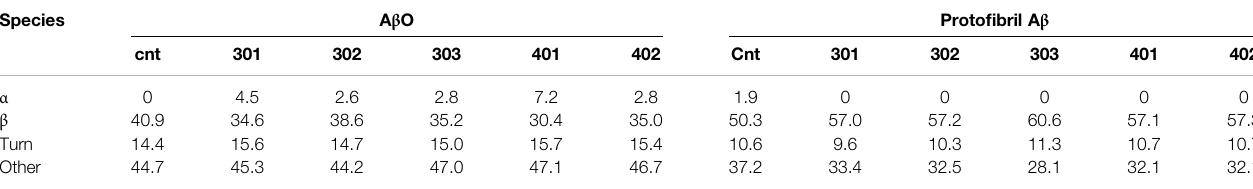
TABLE 1 | Results from the fi tting of the CD spectra by the BeStSel algorithm to estimate fractions of secondary structure in A β samples. Species A β O Proto fi bril A β cnt